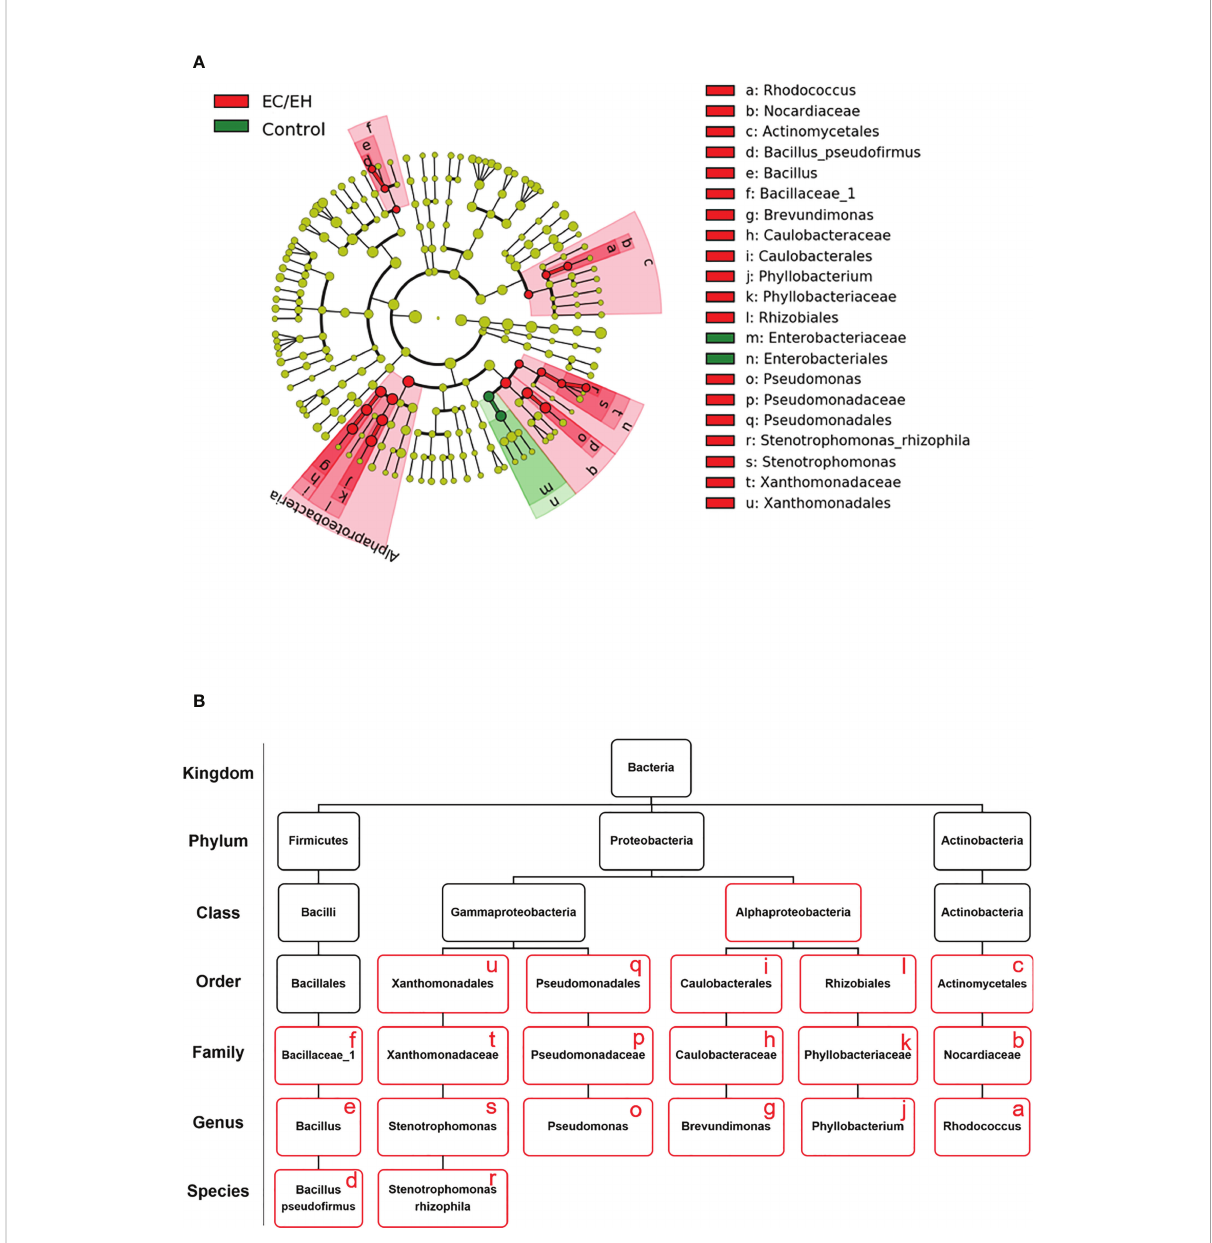
FIGURE 5 Taxonomic pro fi les of endometrial lavage microbiota in patients with EC/EH versus control women: results of linear discriminant analysis of effect size (LEfSe). (A) Cladogram plots were generated to visualize signi fi cantly enriched bacterial taxa in the two study groups. (B) Summary of bacterial taxa showing signi fi cant differences between patients with EC/EH versus control women (red